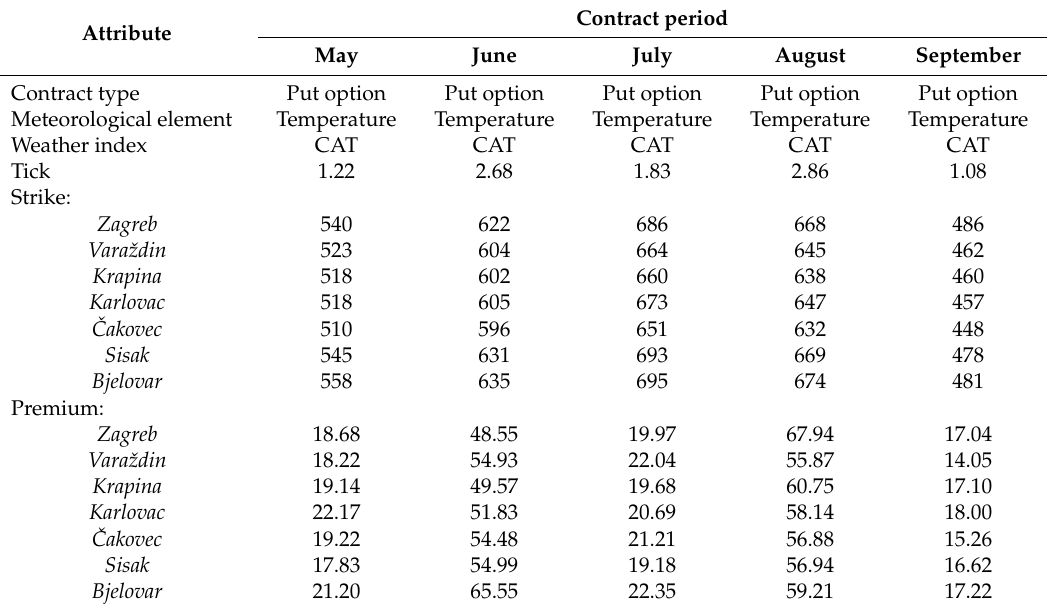
Table 3. Attributes of designed weather